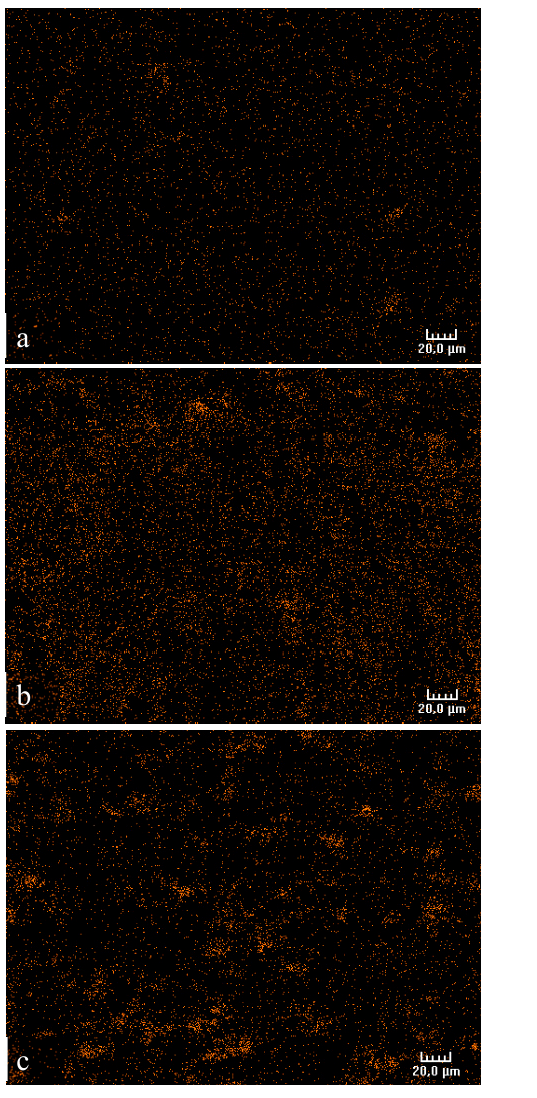
(Figure 1b). The highest ZVI concentration (5% w / w ) in analyzed ZVI / PLA films led to the formation of areas with larger Fe particles concentration (Figure 1c).